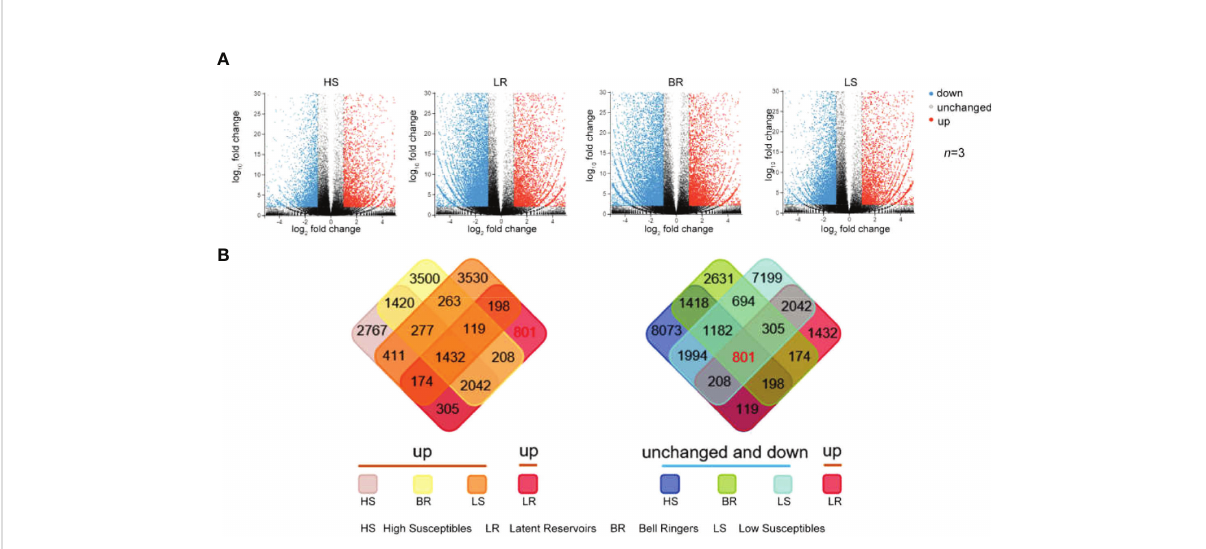
FIGURE 3 Identi fi cation of upregulated Latent Reservoirs-Related genes. (A) Scatter plots of genes expressed in response to PWN according to the library data of 4 types of trees ( t test, n = 3). The expression level was normalized by the average number of FTPM according to the log 2 (fold change) of the normalized reads and the -log 10 (fold change) of the P value. The blue, red, and gray data points represent downregulated genes, upregulated genes or genes whose expression was unchanged. (B) Intersections of upregulated genes in Latent Reservoirs and all genes in the other three